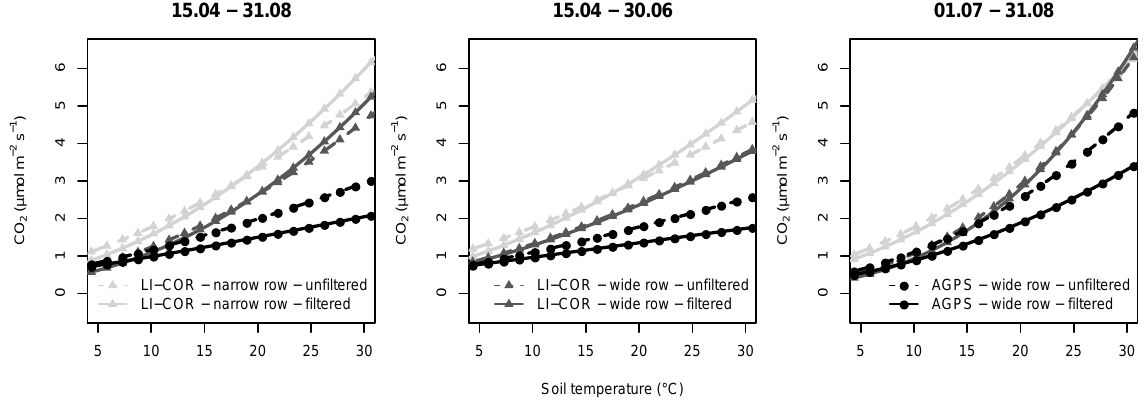
Figure 6. The Lloyd and Taylor model fitted with the different CO 2 flux data sets for the entire monitoring period (15 April–31 August 2014), and separately for the open and closed canopy phase (15 April–30 June 2014 and 1 July–31 August 2014 respectively) using soil temperature at 5cm depth.